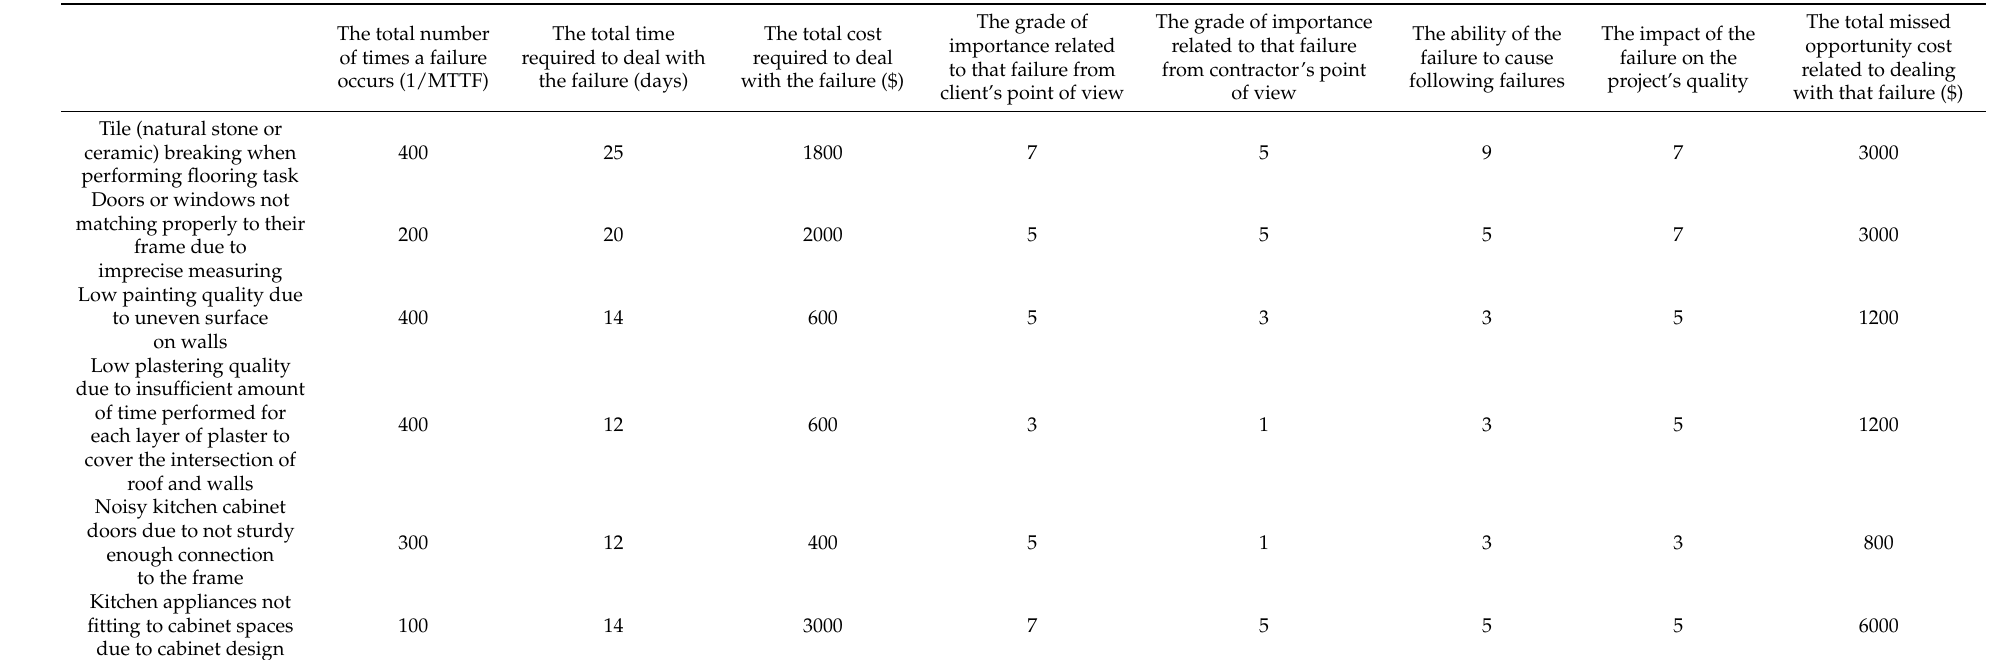
Table 5. The decision matrix for identifying the most critical potential